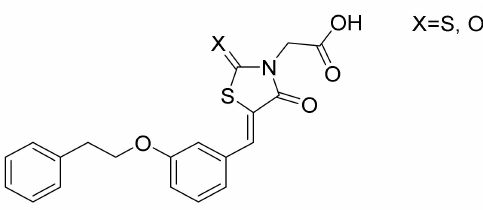
Figure 10. General structure of aldose reductase (AR) / protein tyrosine phosphatase 1B (PTP1B)